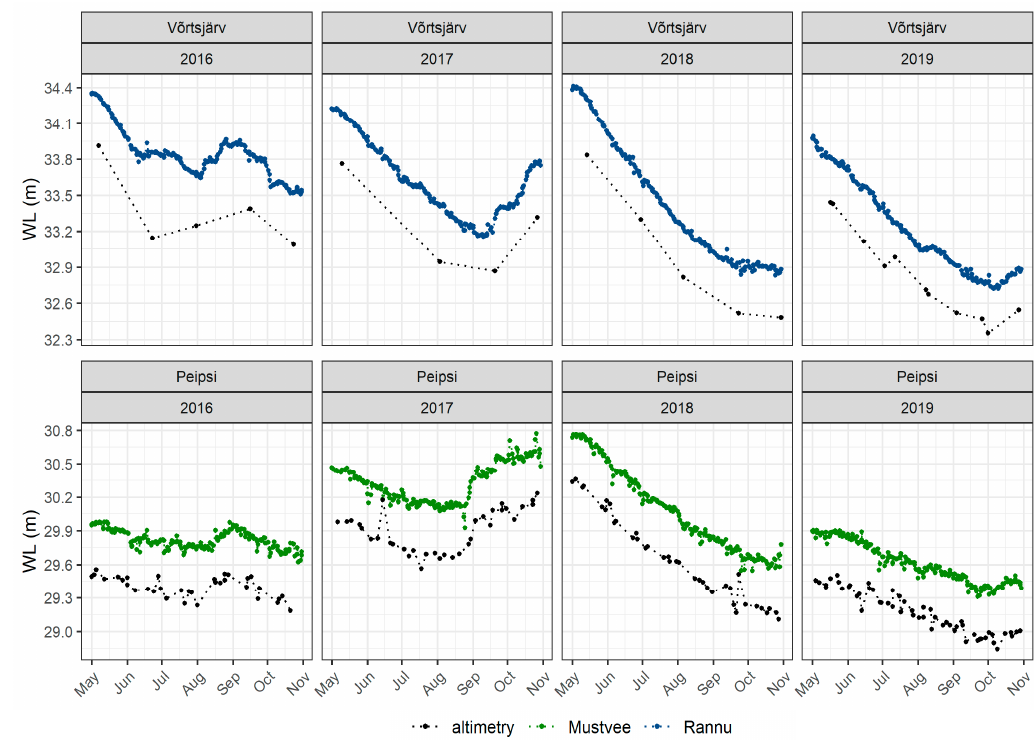
Figure 3. Water level (WL) measured in Mustvee and Rannu hydrometric stations from May to October. WL derived from altimetry data (S3A, S3B, C2).